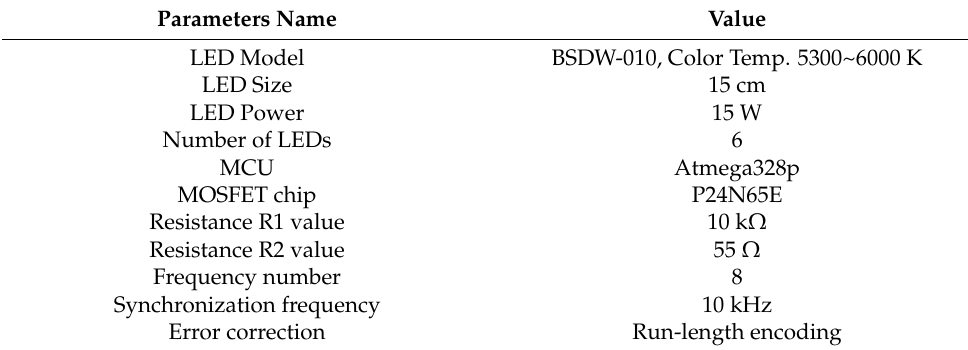
Table 1. Transmitter parameters